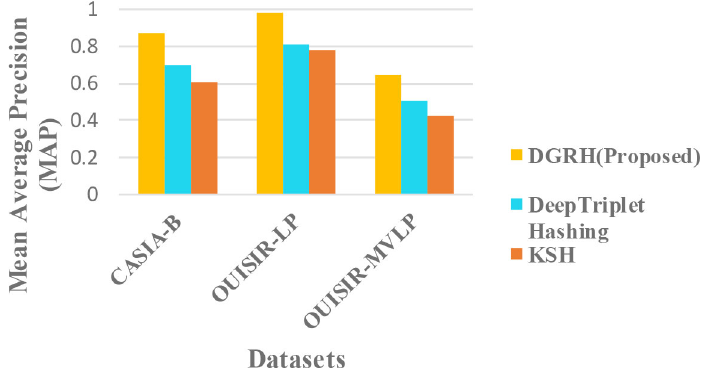
Figure 7. Comparison of the mean average precision MAP in different